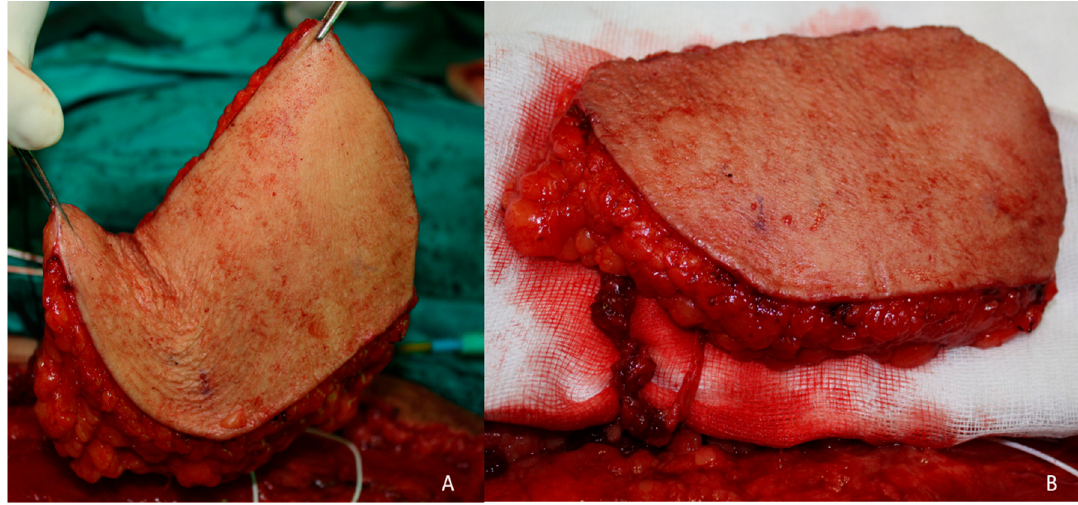
Figure 9. ALT flap. Anterolateral thigh flap based on two perforators prior to section of the vascular pedicle.